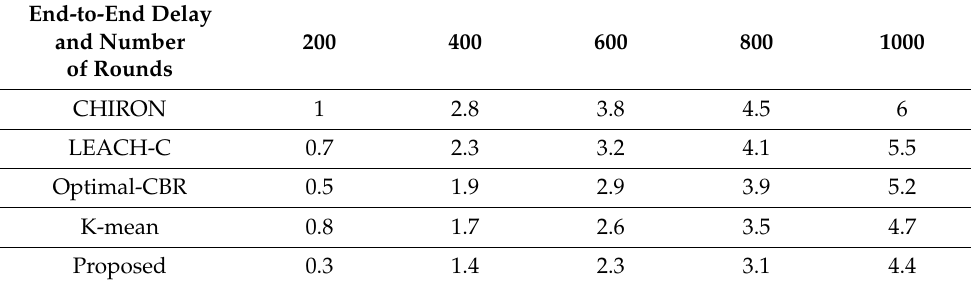
Table 4. Differentiation of end-to-end delay by several methods.